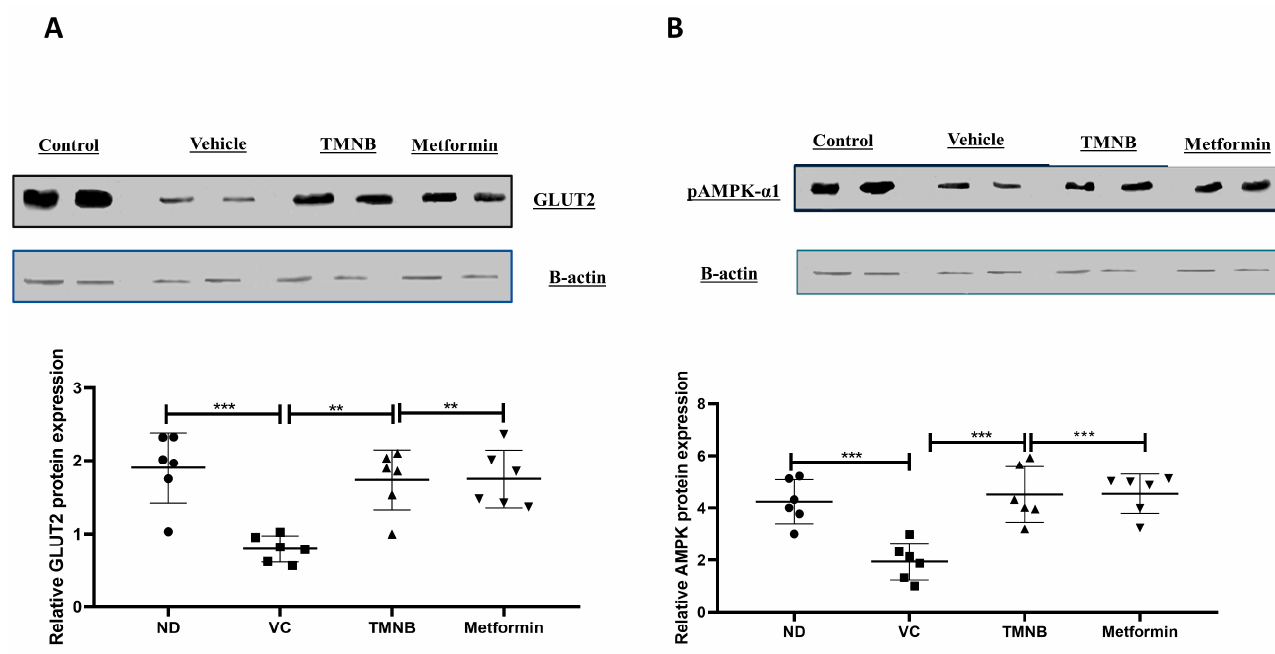
Figure 5. 2 ′ ,3,3,5 ′ -Tetramethyl-4 ′ -nitro-2 ′ H-1,3 ′ -bipyrazole upregulated GLUT2 and AMPK expres- sion in liver. TMNB significantly upregulated hepatic GLUT2 ( A ) and AMPK ( B ) expression in dia- betic rats. Rats were fed HFD for 3 weeks, followed by a single dose of STZ injection (40 mg/kg); and once diabetes was confirmed, rats were treated with 10 mg/kg TMNB or 200 mg/kg metformin for 10 days. At the end of the experiment following euthanasia, liver was isolated and homogenized before being used western blotting. One-way ANOVA was followed by Tukey post-hoc multiple comparison test, ** < 0.01, *** < 0.001. ND; non-diabetic, VC; vehicle control, TMNB; 2 ′ ,3,3,5 ′ -Tetra- methyl-4 ′ -nitro-2 ′ H-1,3 ′ -bipyrazole. 3.4. The Effect of 2 ′ ,3,3,5 ′ -Tetramethyl-4 ′ -Nitro-2 ′ H-1,3 ′ -Bipyrazole (TMNB) on Lipid Profile As depicted in Figure 6, dyslipidemia was clearly present in diabetic rats. LDL (Fig- ure 6A, n = 6, p < 0.001), total cholesterol (Figure 6B, n = 6, p < 0.05), and triglycerides (TGs; Figure 6C, n = 6, p < 0.01) were significantly higher in the vehicle control diabetic group compared to the non-diabetic group. Treating diabetic rats with TMNB significantly re- duced serum LDL (Figure 6A, n = 6, p < 0.001), total cholesterol (Figure 6B, n = 6, p < 0.01), and TGs (Figure 6C, n = 6, p < 0.001systemic concentration compared to the vehicle control diabetic group. Similarly, metformin was able to significantly reduce LDL (Figure 6A, n = 6, p < 0.05), cholesterol (Figure 6B, n = 6, p < 0.01), and TGs (Figure 6C, n = 6, p < 0.001) levels in diabetic rats compared to vehicle controls.